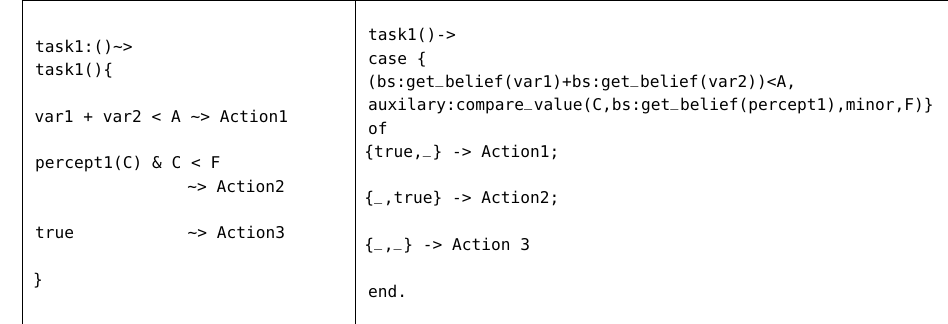
Table 6. From TeleoR condition on variables (left) to Erlang equivalent